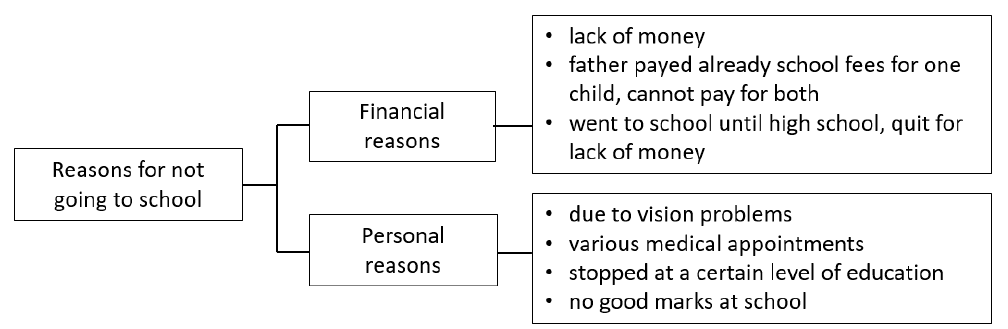
Figure 6. Reasons for not going to school.